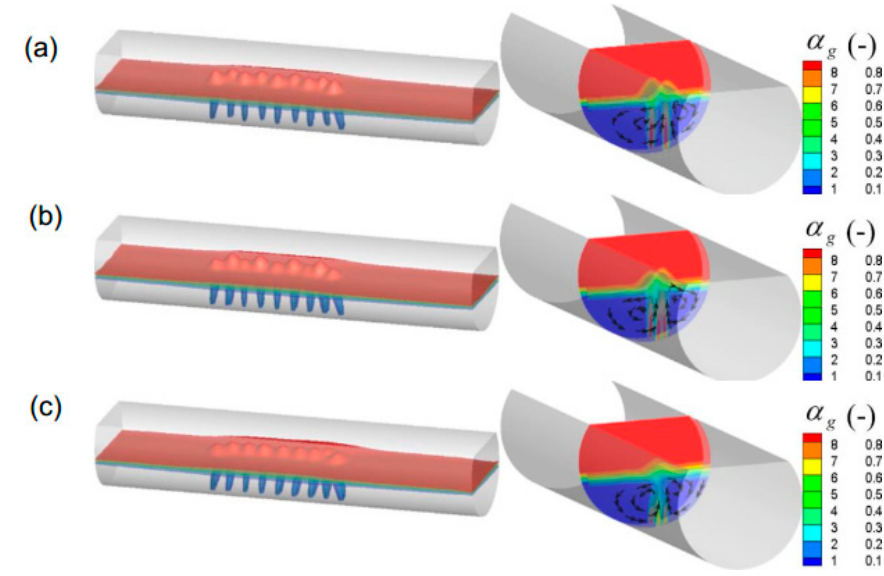
Figure 11. Predicted local gas volume fraction in the bath with different numbers of nozzles, and the nozzle numbers are ( a ) 9, ( b ) 13, and ( c ) 18, respectively.